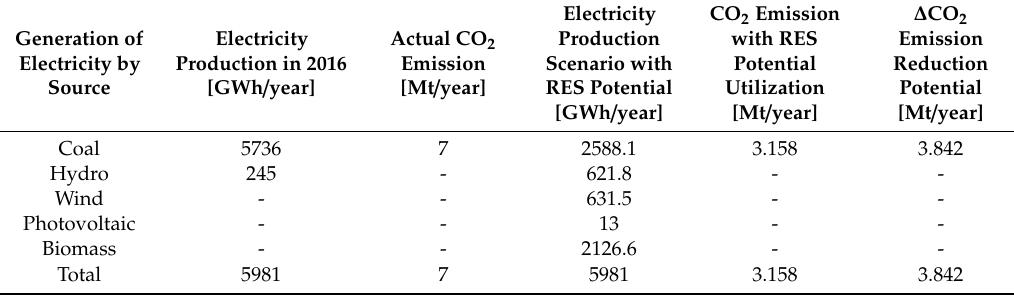
Table 9. Actual annual electricity generation by source for a referent year (2016) and potential electricity generation by RES in Kosovo.